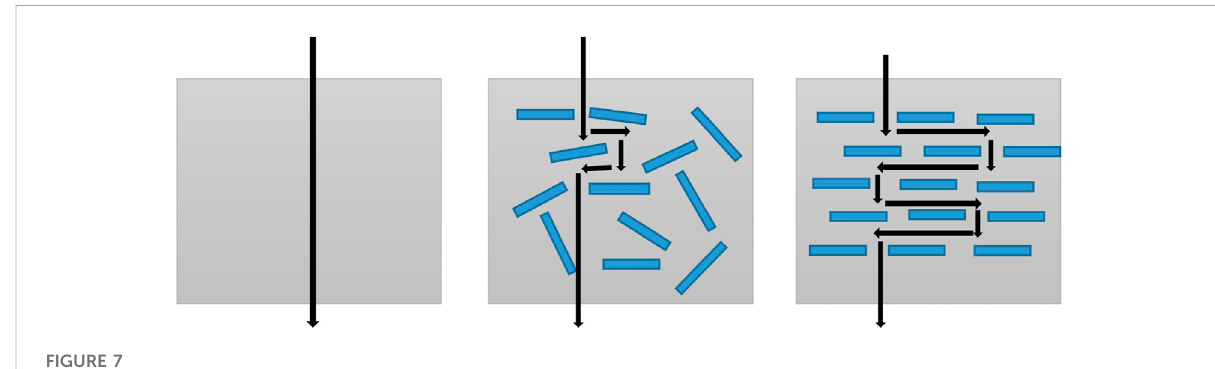
FIGURE 7 Mechanism of gas barrier in